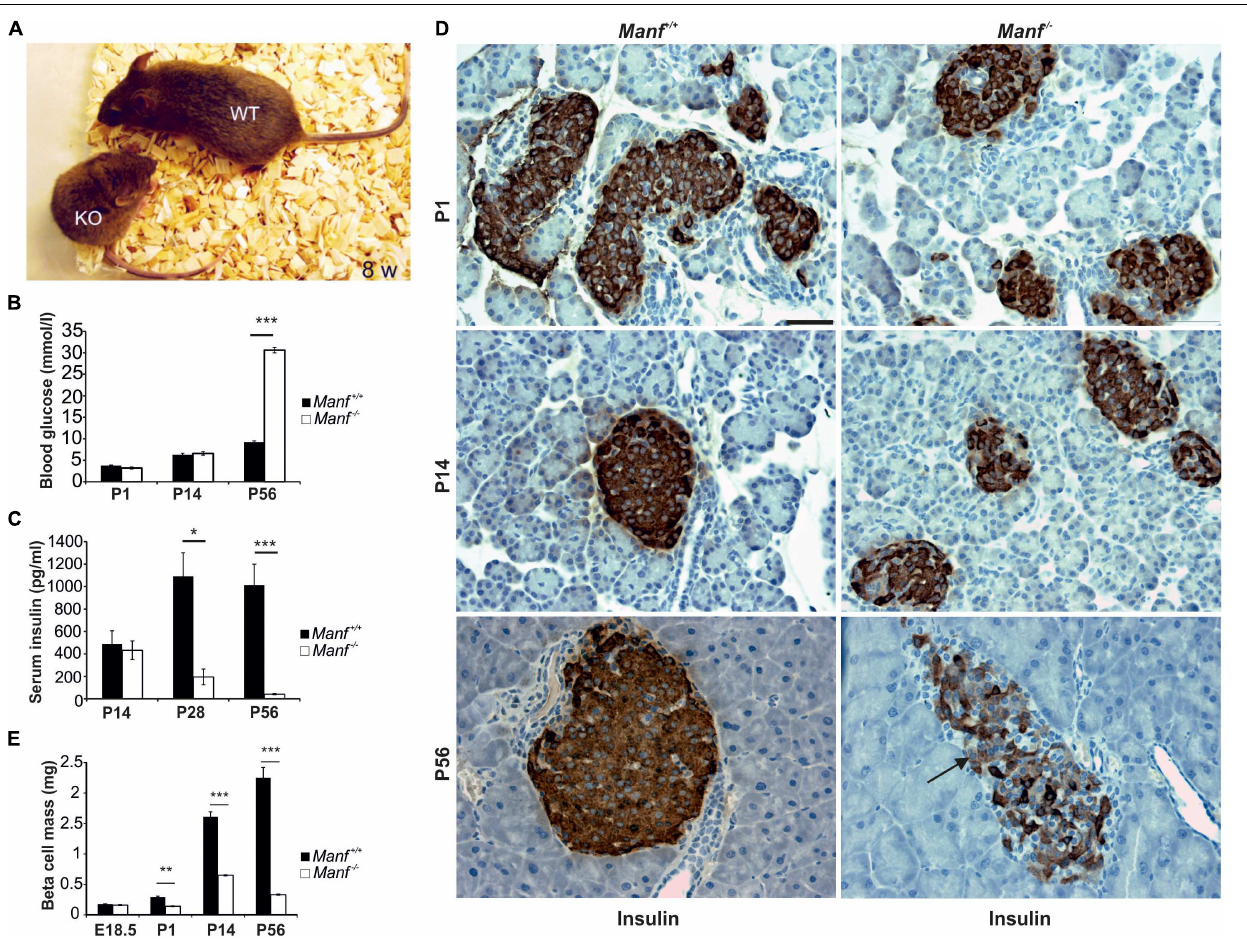
FIGURE 2 | MANF-deficient mice develop insulin-dependent diabetes caused by progressive decrease in beta cell mass. (A) Manf − / − mice at 8 weeks of age show a severe growth defect compared to WT littermates. (B,C) Manf − / − mice develop diabetes, characterized by increased blood glucose levels (B) and decreased serum insulin levels (C). (D) Histological analysis revealed reduced insulin staining, reduced islet size and number of beta cells in pancreases of newborn, 2 and 8 weeks old Manf − / − pancreases. (E) Progressive loss of beta cell mass in Manf − / − mice compared to controls. Images in (B–E) modified from Lindahl et al. (2014). Scale bar, 50 µ